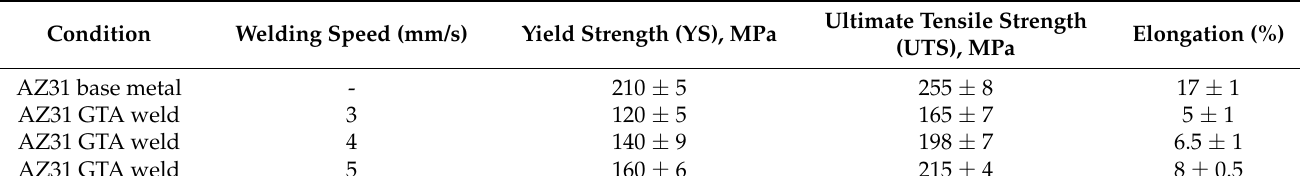
Table 3. Tensile properties of AZ31 base metal and GTA welded joints made at different welded speeds.